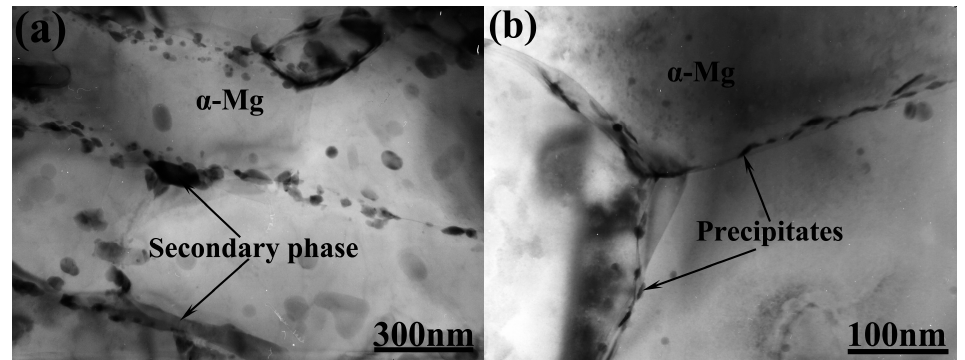
Figure 8. Bright-field TEM micrograph of the precipitate and phase in the hot extruded Mg–Zn–Y–Nd alloy: ( a ) morphology of the precipitates array along the extrusion direction in the one-pass hot extruded alloy, ( b ) morphology of the precipitates along grain boundaries in the two-pass hot extruded alloy.